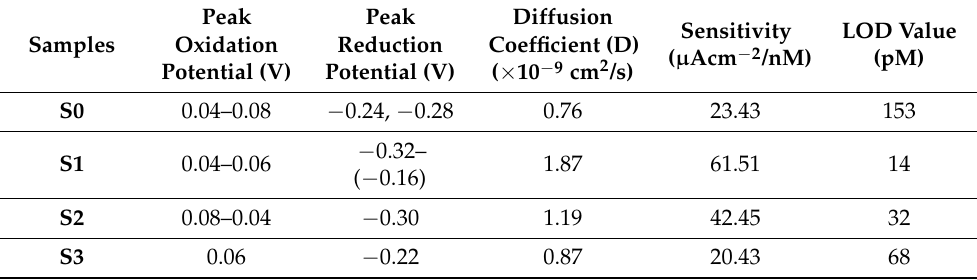
Table 1. Estimated sensing parameters for the fabricated Mb biosensor based on pure and Cu-doped TiO 2 nanomaterials.